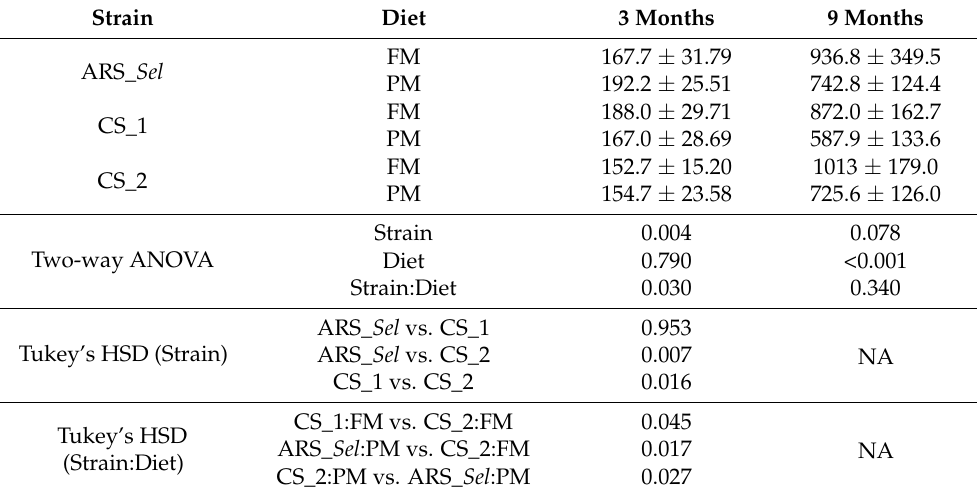
Table 1. Fish weights (g) by diet and fish strain after 3 and 9 months on treatment diets. Weights are listed as mean ± SD (n = 10). Tukey’s HSD post-hoc test was used to conducted pairwise tests under the full model when significant main effects were detected. Only significant group comparisons are listed for the strain:diet interaction post-hoc test. Significant p -values are italicized (NA: not